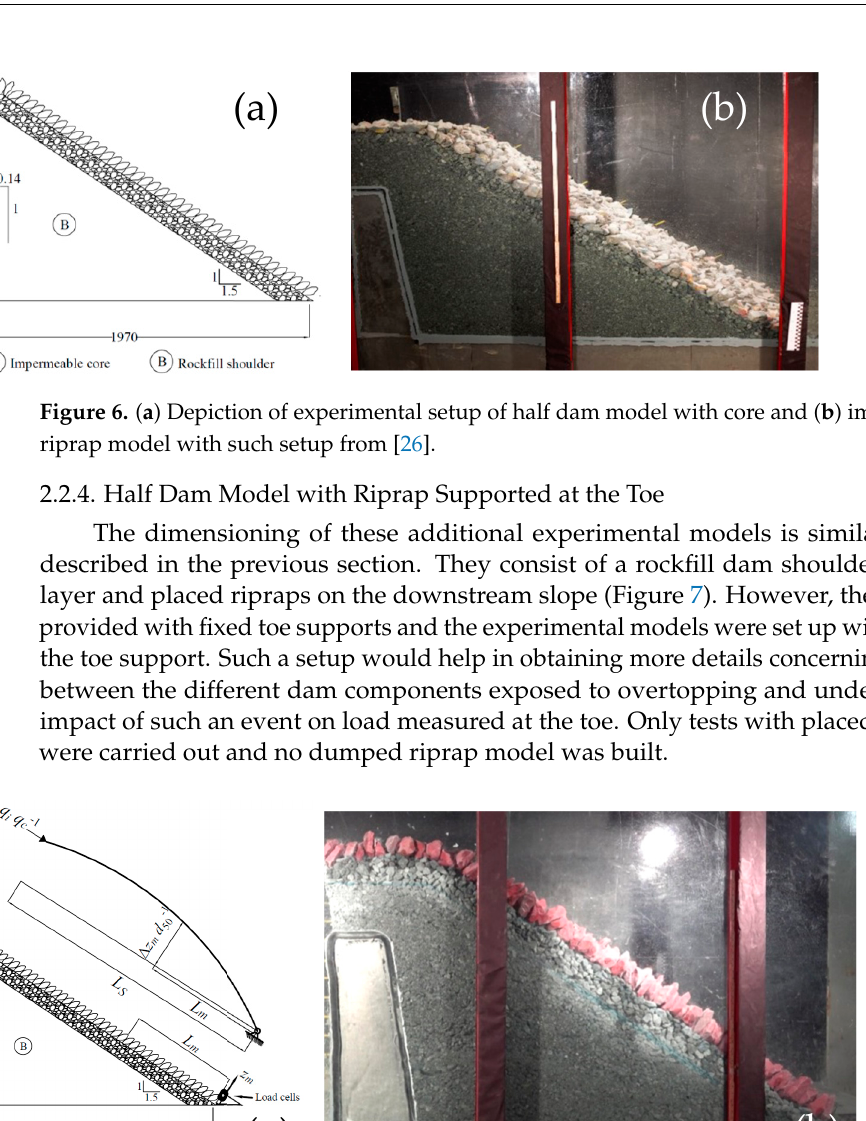
Figure 8. ( a ) Depiction of experimental setup of full dam model with flexible core, and ( b ) image of placed riprap model with such a setup. 2.3. Overtopping Procedure The experimental models were exposed to successive overtopping events with in- creasing water discharge levels supplied by pumps (Figure 3) for a combined maximum (a)